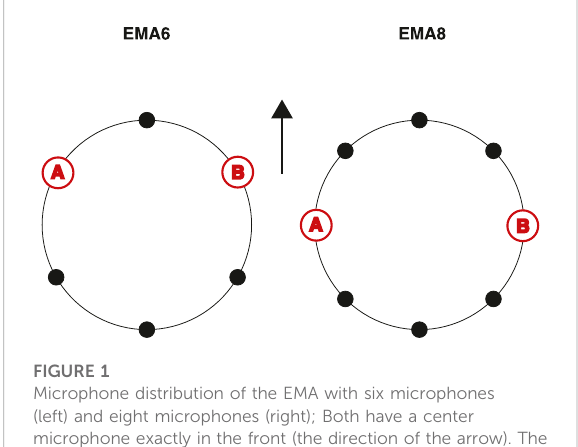
FIGURE 1 Microphone distribution of the EMA with six microphones (left) and eight microphones (right); Both have a center microphone exactly in the front (the direction of the arrow). The microphones used for AB stereo are indicated with “ A ” and “ B ” . Only the EMA with eight microphones has microphones at ϕ =90 ° and ϕ =270 °